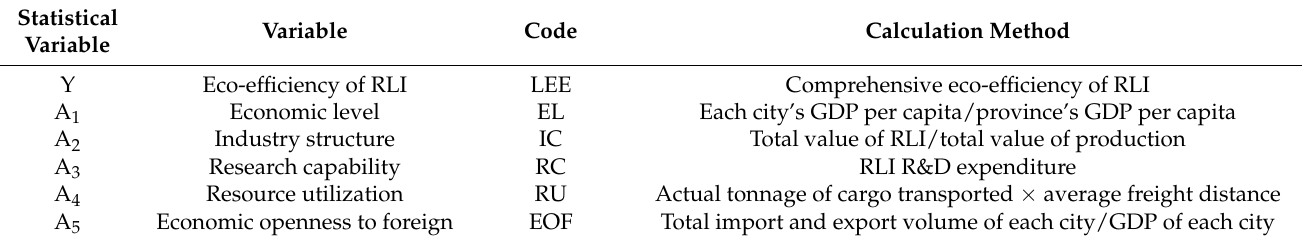
Table 2. Main influencing indicators of RLI